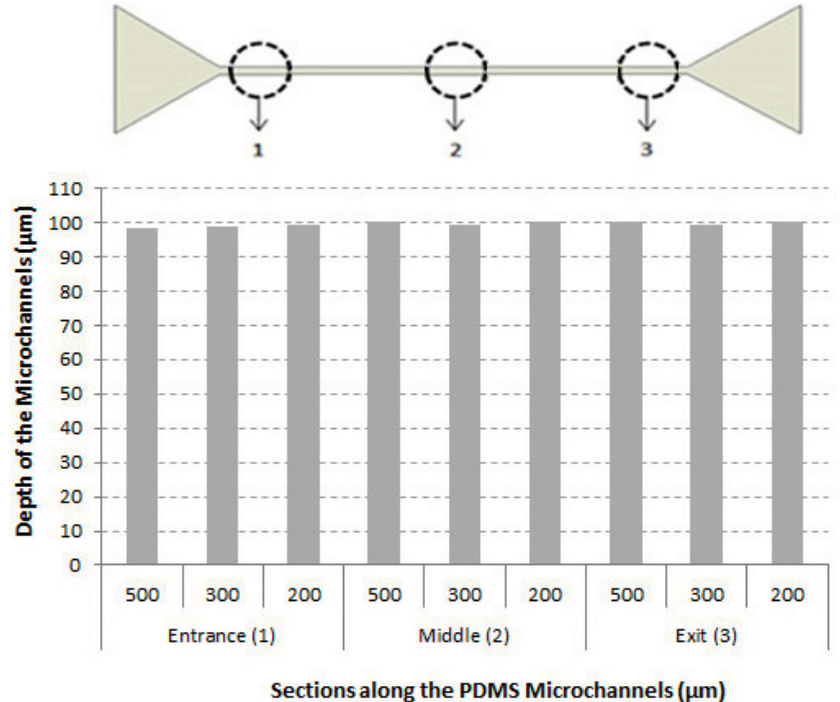
Figure 8. Depth measurements in three different sections: entrance ( 1 ), middle ( 2 ), and exit ( 3